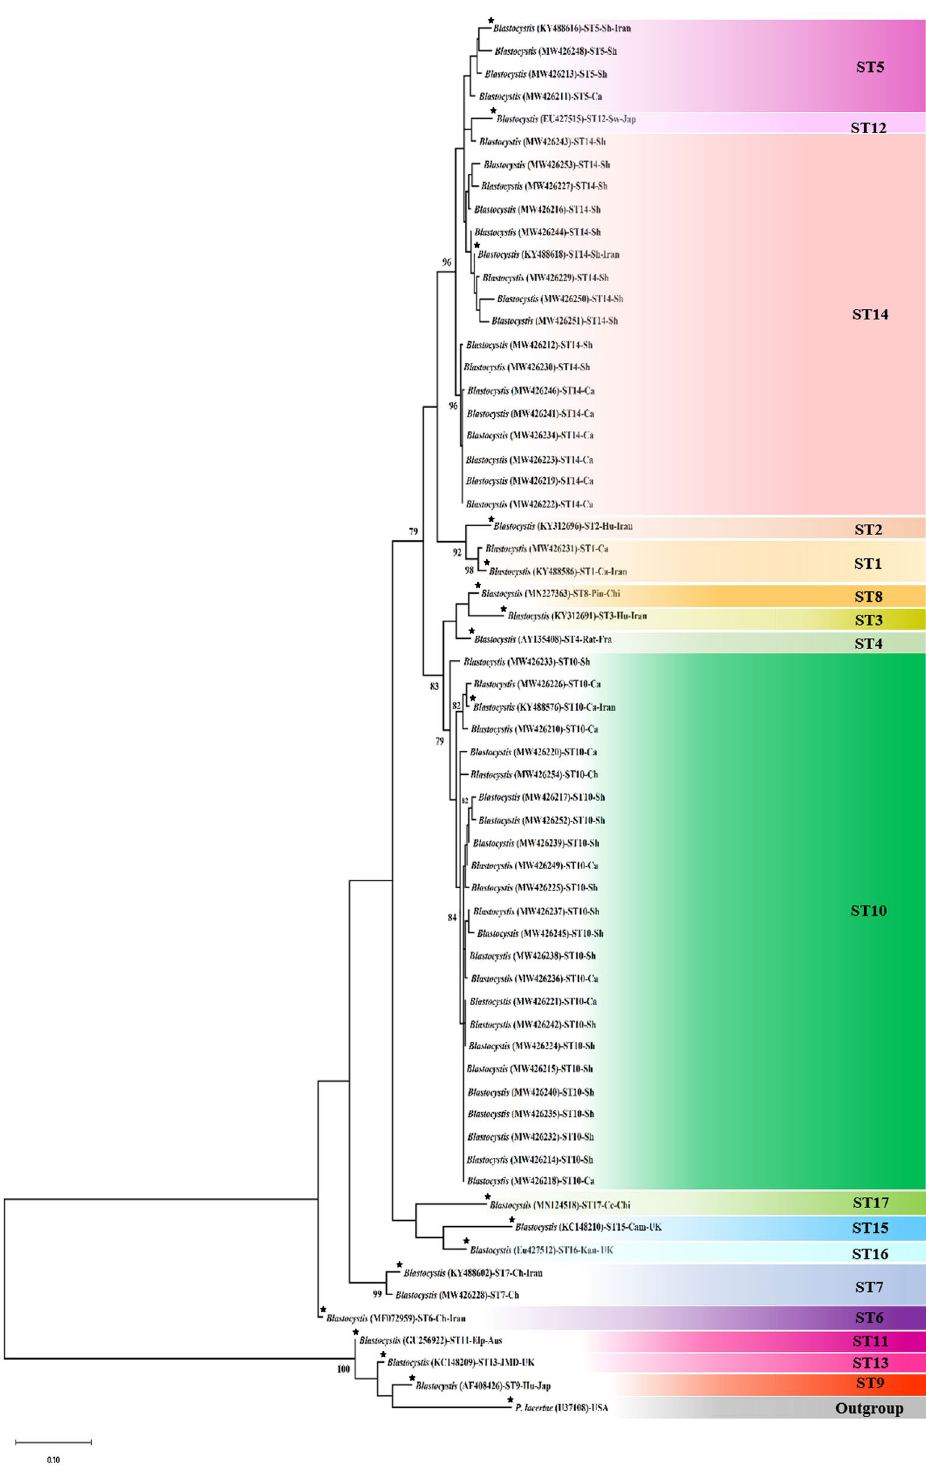
Figure 2. Phylogenetic tree of the barcoding fragment of Blastocystis sp. isolated from cattle, sheep, chicken, and horses together with reference sequences. The phylogenetic tree represents that all identified subtypes were clearly clustered. The phylogenetic tree was drawn using the maximum-likelihood method and the Tamura 3-parameter model. Bootstrap support (%) values of > 75% are indicated above the branches. Asterisks